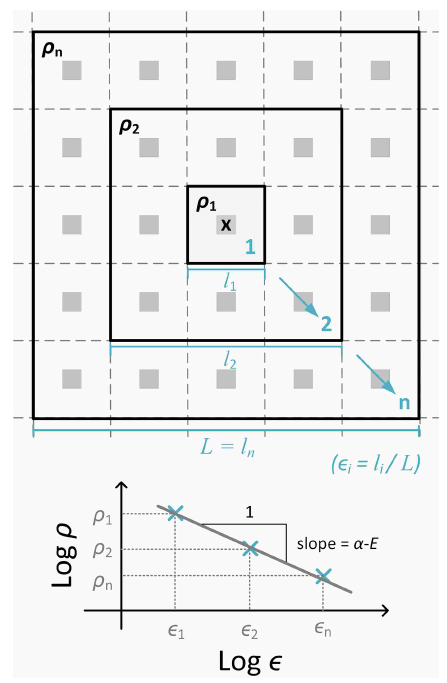
Figure 2. Schematic of the local singularity analysis (adapted from Wang et al.,